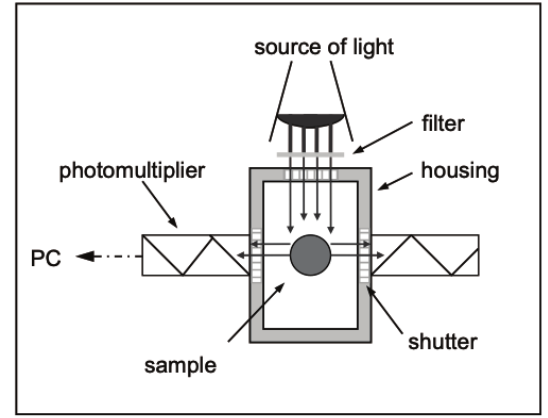
Figure 1: Schematic overview of the FES measuring